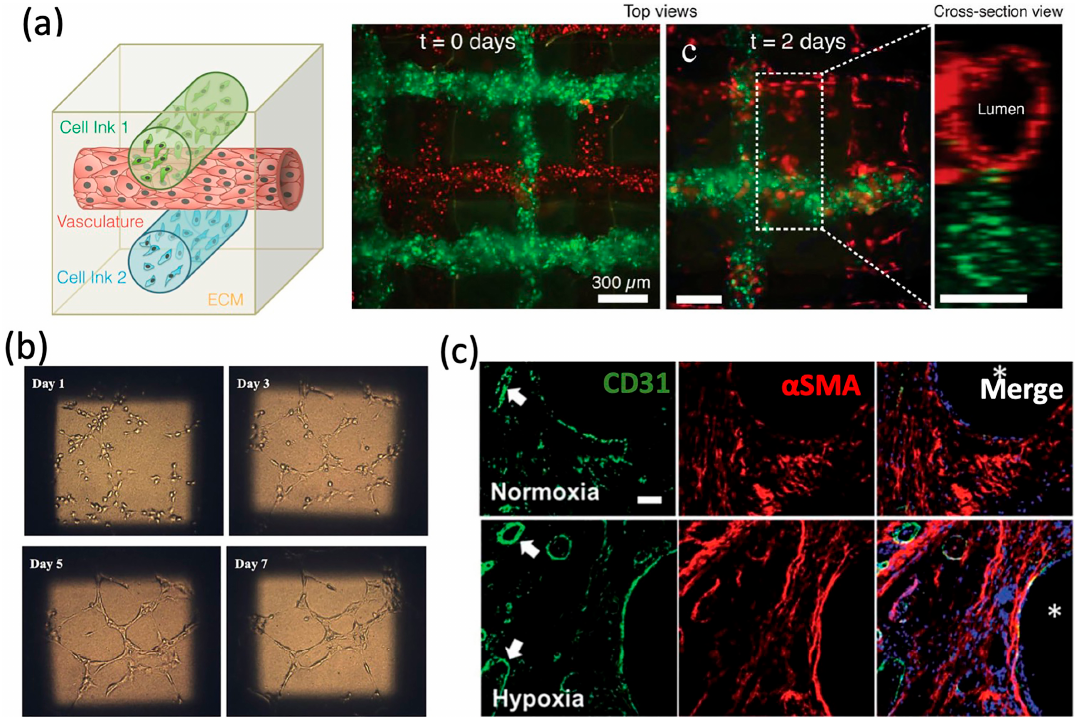
Figure 4. Cell-based approaches for vascular networks. ( a ) Schematic view and fluorescence images of an engineered tissue construct cultured for 0 and 2 days, respectively. ( b ) The tube formation of HUVEC-laden hydrogel/PDACS/PCL scaffold. ( c ) CD31, aSMA, and nuclei staining for 3D bioprinted constructs. Reprinted with permission from References [133,145,147] .